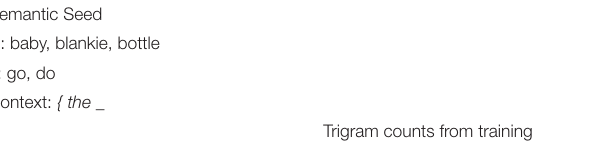
TABLE 3 | Example of how the left context model would decide how to categorize a target word in two different scenarios. Semantic Seed N: baby, blankie,